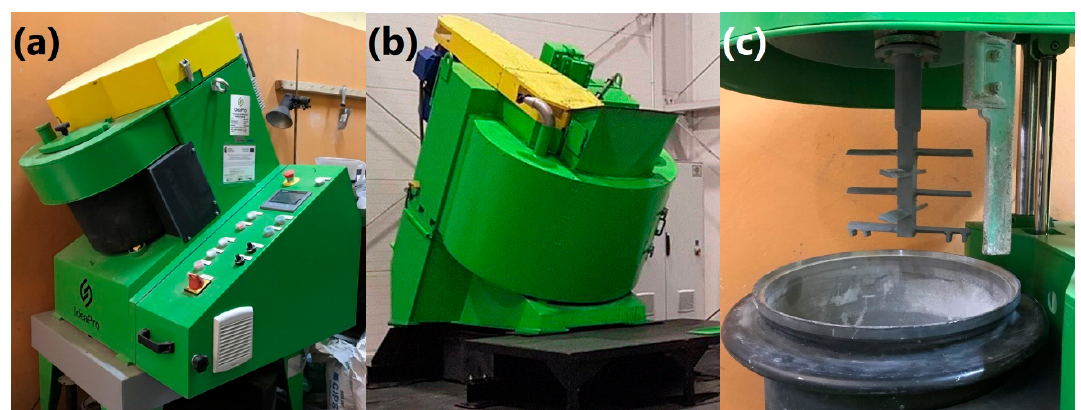
Figure 1. Intensive mixers with ( a ) 30 L and ( b ) 500 L agitator bowls, and ( c ) star-belt type stirrer present in applied mixers. Table 2. The composition of prepared granulates further sintered into lightweight aggregates (LWAs).